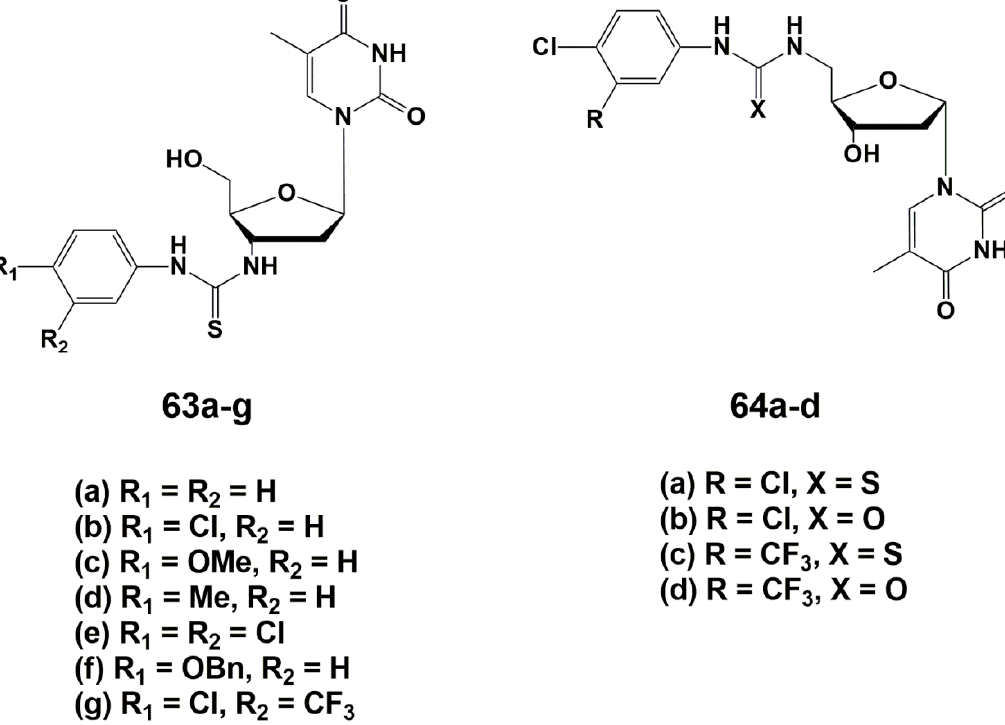
TMPK mtb ( Ki 42 µM) (Figure 16).